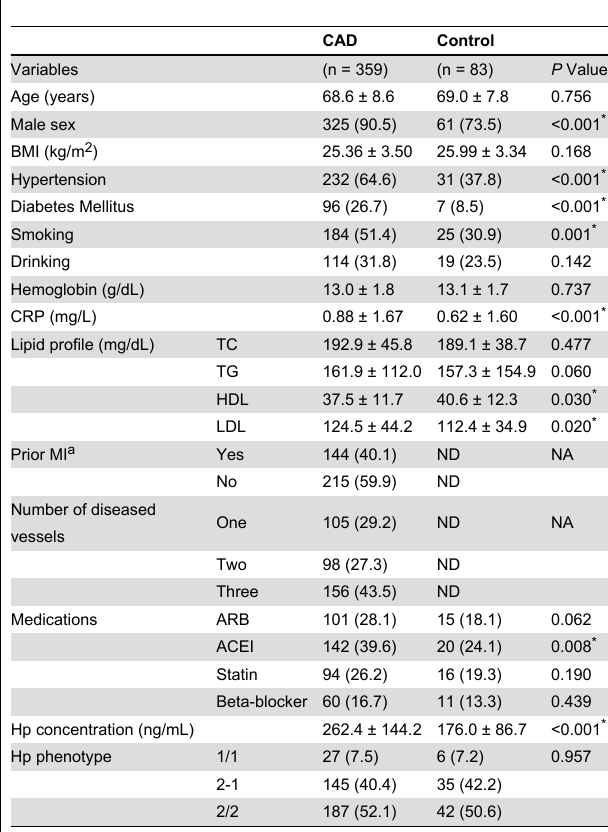
Table 1. Baseline characteristics of study participants (N =